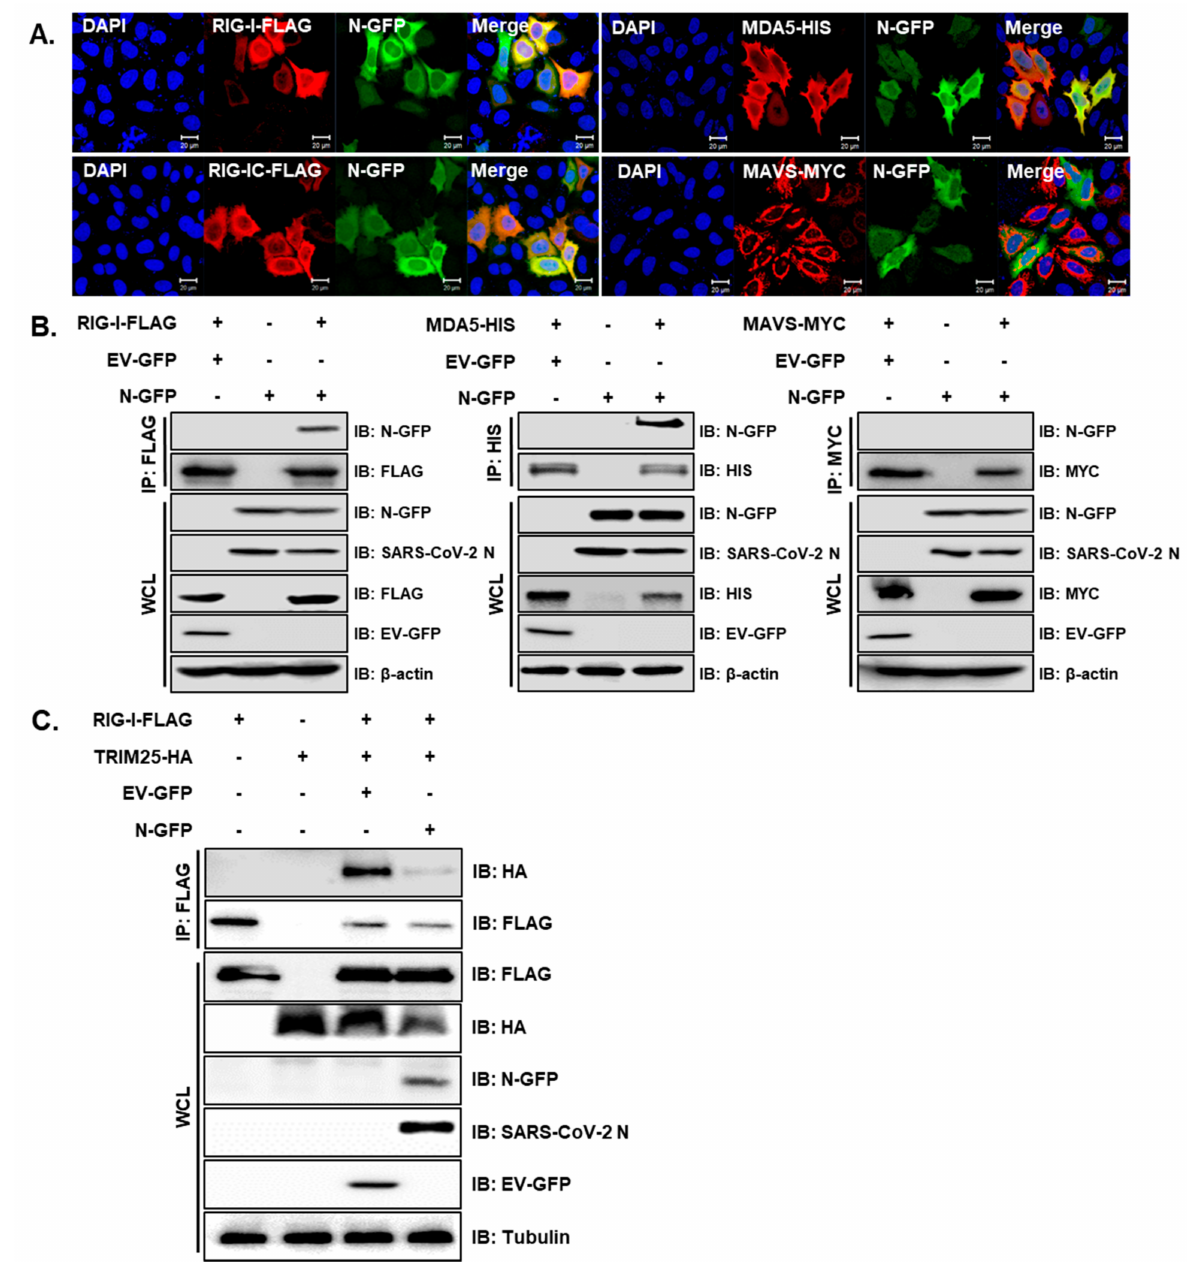
Figure 2. SARS-CoV-2 N interacts with genes involved in the RLR signaling pathway and interferes RIG-I interaction with TRIM25. ( A ) HeLa cells were transiently transfected with the following plasmids: RIG-I-FLAG, RIG-IC-FLAG, MDA5-HIS and MAVS-MYC along with SARS-CoV-2 N-GFP-encoding plasmids. Cells were fixed in paraformaldehyde and permeabilized with 0.1% Triton X-100. The images are representative of three independent experiments. Scale bar = 20 µ m. ( B ) HEK293T cells in 6-well plates were transfected with RIG-I-FLAG or MAVS-MYC plasmids along with empty vector with GFP tag (EV-GFP) or SARS-CoV-2 N-GFP (N-GFP) plasmids. After 24 h, cells were lysed and immunoprecipitated with indicated antibodies. Whole cell lysates (WCL) and immunoprecipitates were analyzed by immunoblot analysis. ( C ) HEK293T cells transfected with plasmids encoding RIG-I-FLAG or TRIM25-HA along with EV-GFP or N-GFP-encoding plasmids were lysed and subjected to immunoprecipitation with anti-FLAG tag antibody. The cell lysates and immunoprecipitates were analyzed by immunoblot analysis using indicated